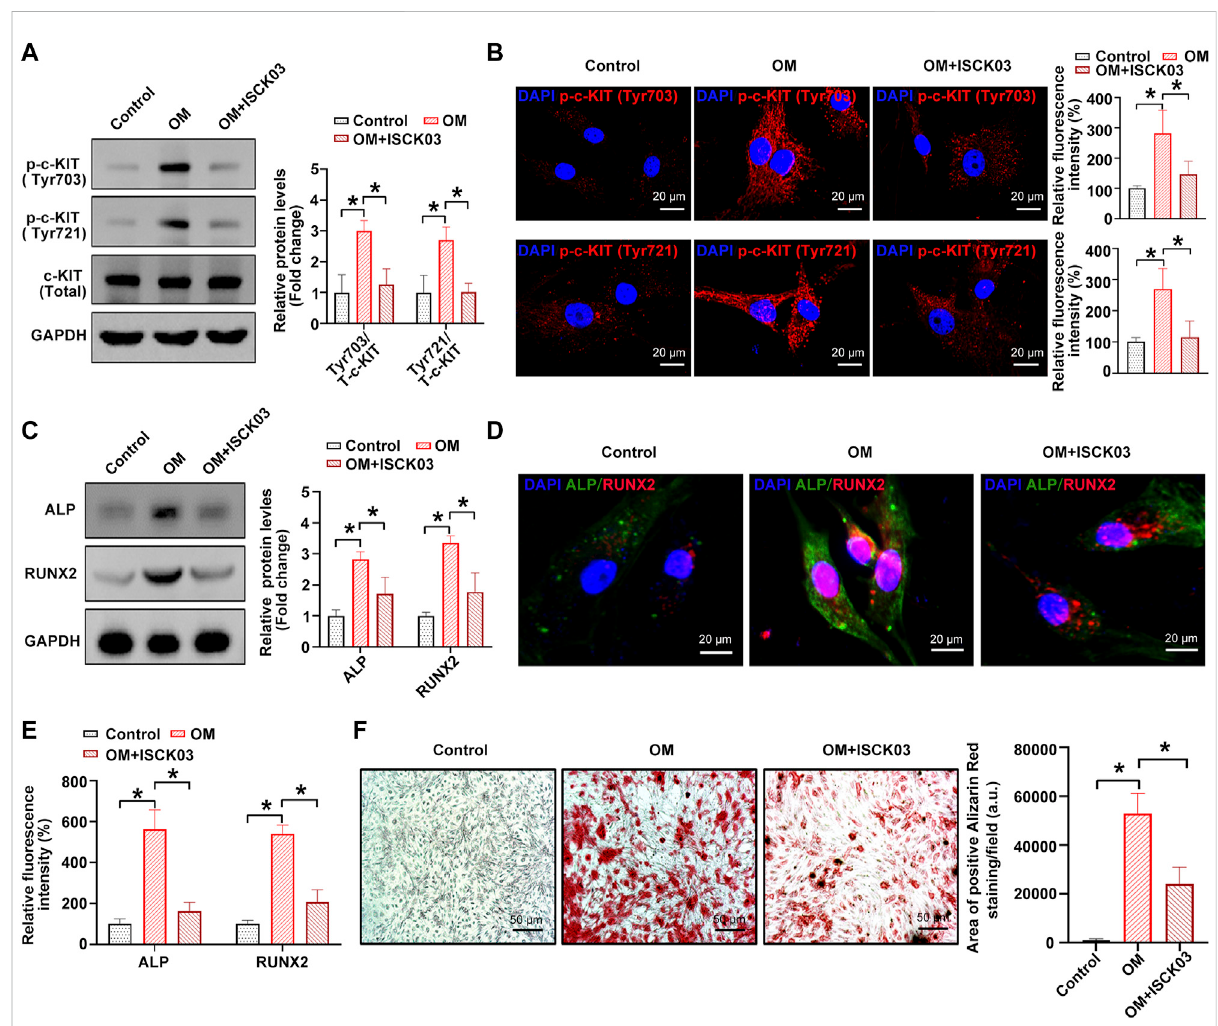
c-KIT inhibition prevents the osteogenic differentiation of human valvular interstitial cells (hVICs). Western blotting (A) and immuno fl uorescent staining (B) were used to con fi rm the inhibitory effect of ISCK03 (speci fi c inhibitor of c-KIT) on c-KIT activity. One-way ANOVA followed by a Bonferroni post hoc test . Western blotting (C) and immuno fl uorescent staining (D) were used to detect the protein levels of osteogenesis-speci fi c genes (alkaline phosphatase, ALP, and runt-related transcription factor 2, RUNX2) in human valvular interstitial cells (hVICs) stimulated with osteogenicinductionmedium(OM)andthentreatedwithorwithoutISCK03. (E) Semiquanti fi cationofthe fl uorescenceintensityofRUNX2andALP. One-way ANOVA followed by Bonferroni post hoc test . (F) Alizarin red staining of mineralization nodules in hVICs stimulated with OM and then treated with or without ISCK03. One-way ANOVA followed by Bonferroni post hoc test . N = 3 per group. Values are the mean ± SD. * p < 0.05 indicates a signi fi cant